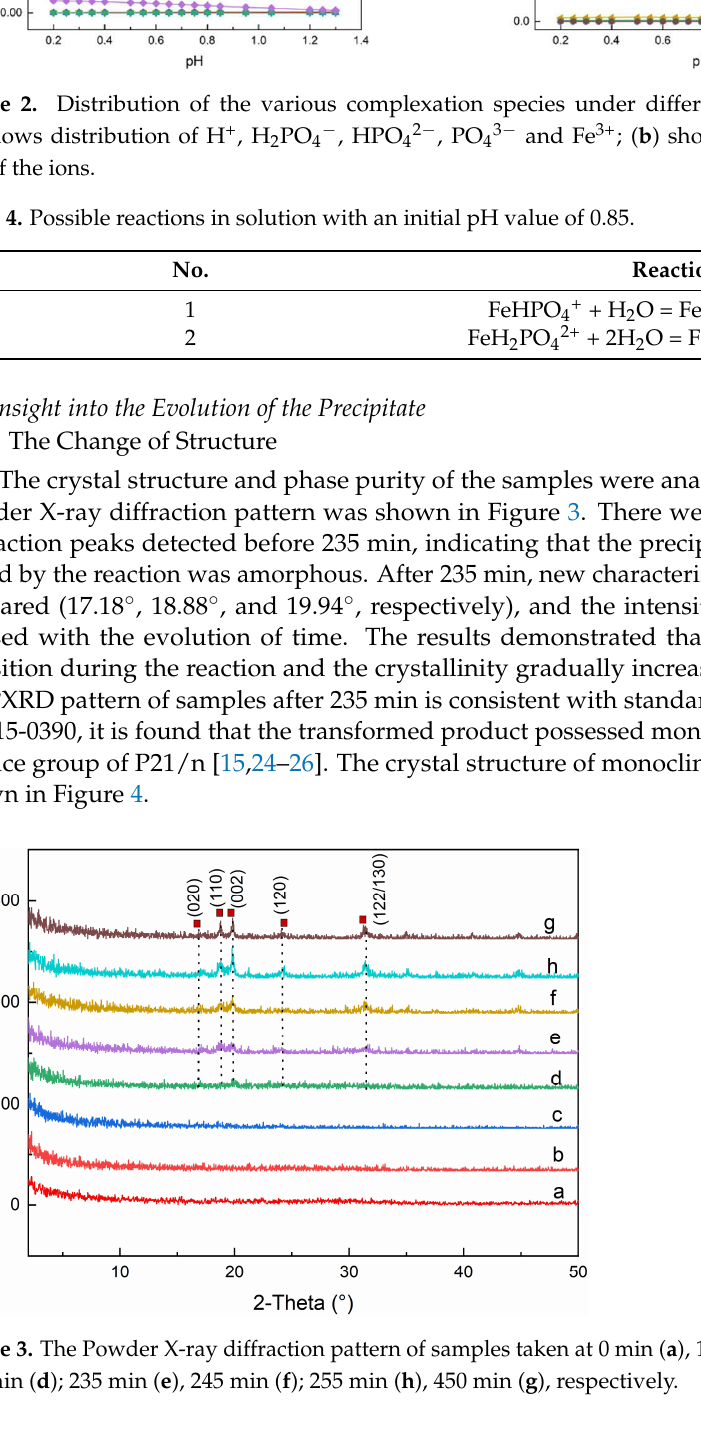
Figure 4. crystal structure of monoclinic FePO 4 ·2H 2 O. 3.2.2. Change of Morphology The morphology during the reaction was studied by SEM and TEM as shown in Fig- ures 5 and 6. At the initial stage of the reaction, the sample mainly exists in the form of amorphous microsheet agglomeration and the average size is about 2 μm to 4 μm, as shown in Figures 5a and 6a. The size of microsheets gradually decreased and the extent of agglomeration increased slightly. They grew and agglomerated together by continuous dissolution–recrystallization. Figure 5c shows that plentiful nanoparticles formed on the surface of agglomerates at 150 min, which were found to be a mixture of mostly amor- phous and little crystalline FePO 4 ·2H 2 O by selected area electron diffraction (SAED)— which shows an inconspicuous diffraction pattern, as shown in Figure 6b. But there is still no obvious diffraction peak of powder X-ray diffraction pattern at this time, at which the content of crystalline FePO 4 ·2H 2 O is lower than the minimum content standard of powder X-ray diffraction analysis. The monoclinic FePO 4 ·2H 2 O nuclei on the active surface of amorphous agglomerates gradually grew and agglomerated accompanying the dissolu- tion of amorphous FePO 4 ·2H 2 O into ions. Ultimately, dense spheroid-like monoclinic FePO 4 ·2H 2 O particles were produced continuously by dissolution–recrystallization of ag- glomerates. It was proven that the spheroid-like particles are comprised of long flakes of monoclinic FePO 4 ·2H 2 O as illustrated in Figure 6c.